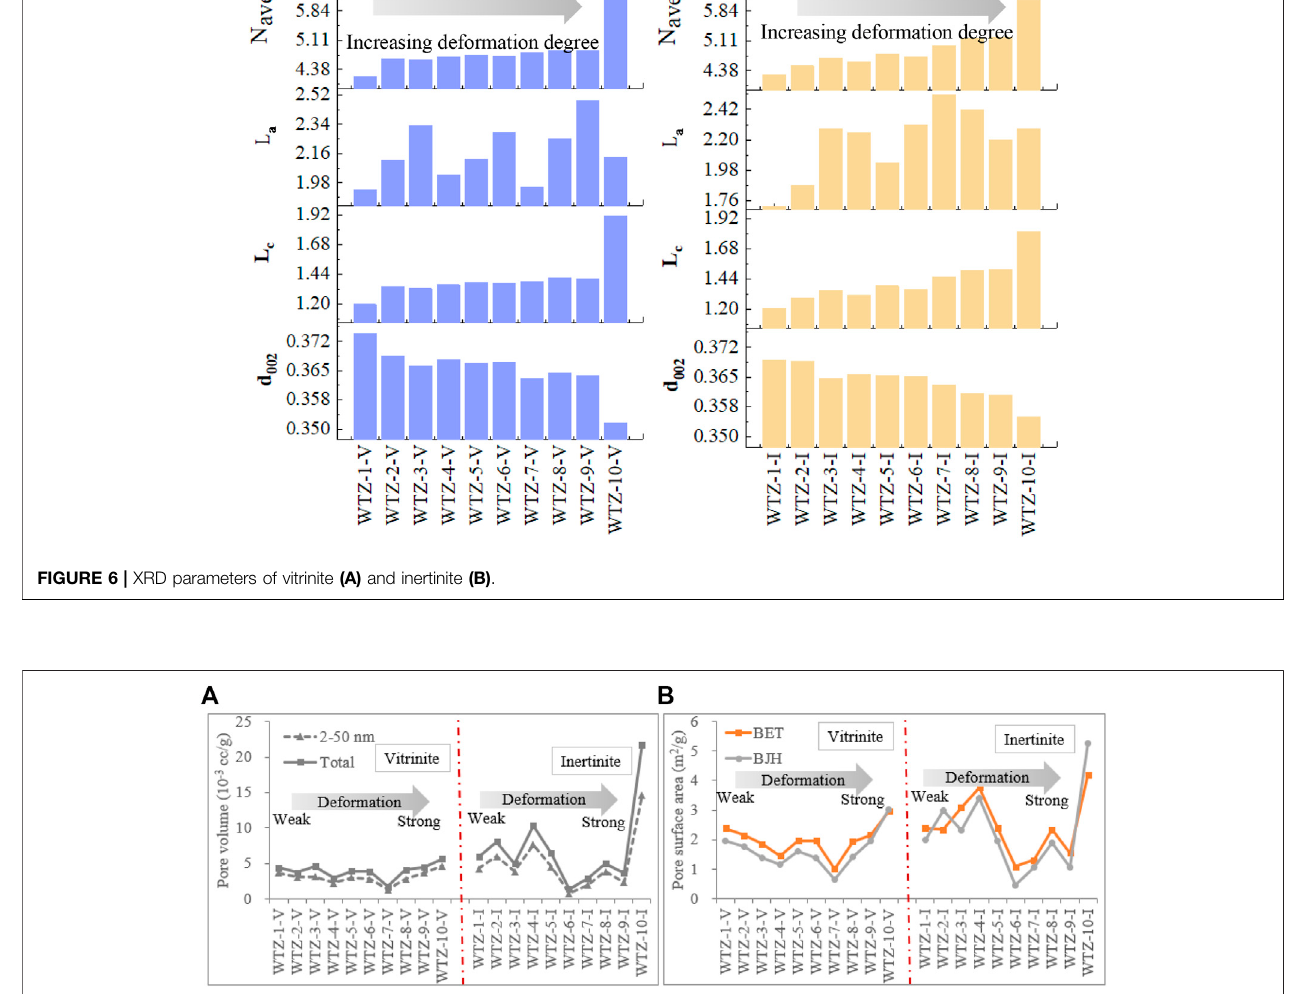
FIGURE 7 | Pore volume (A) and surface area (B) of vitrinite and inertinite.